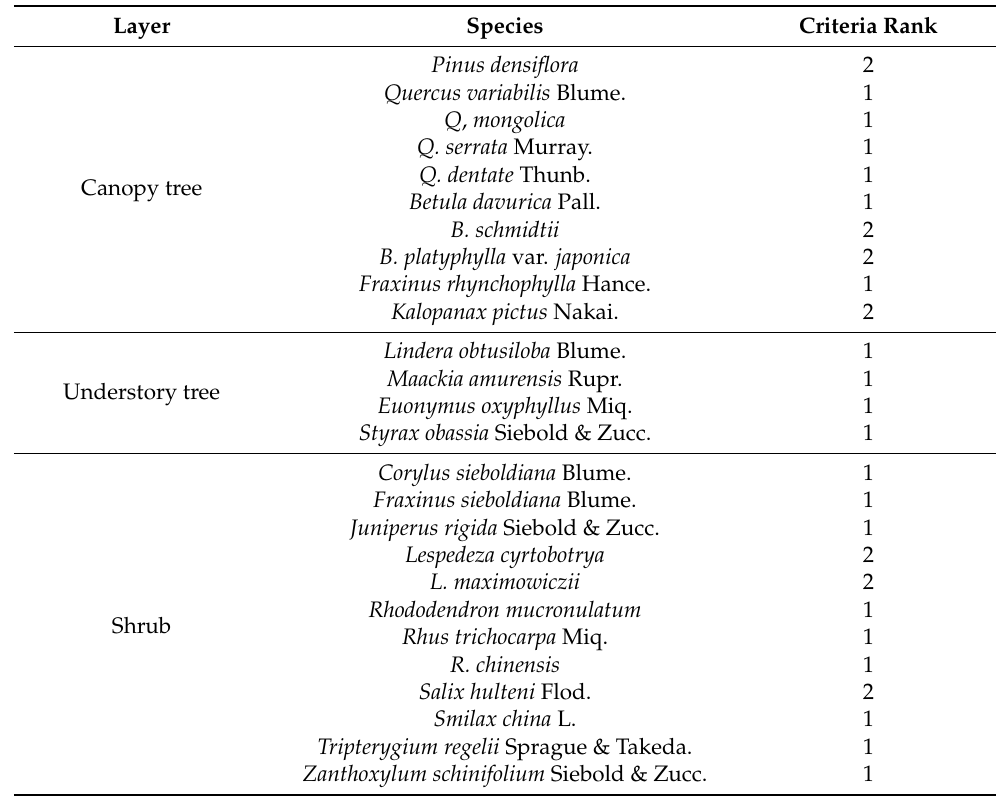
Table 2. Tolerant species selected by field survey in the abandoned coal mine spoils and nearby mountainous land with similar environmental